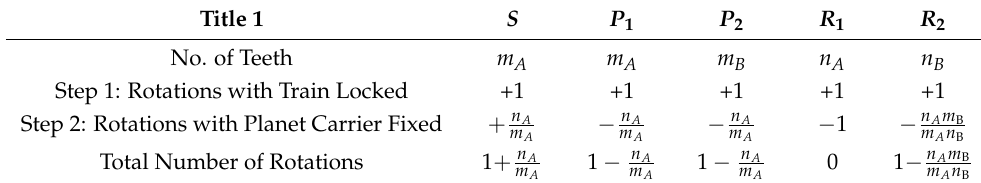
Table 1. Speed ratios for a lobe cam reducer with fixed turret R 1 .